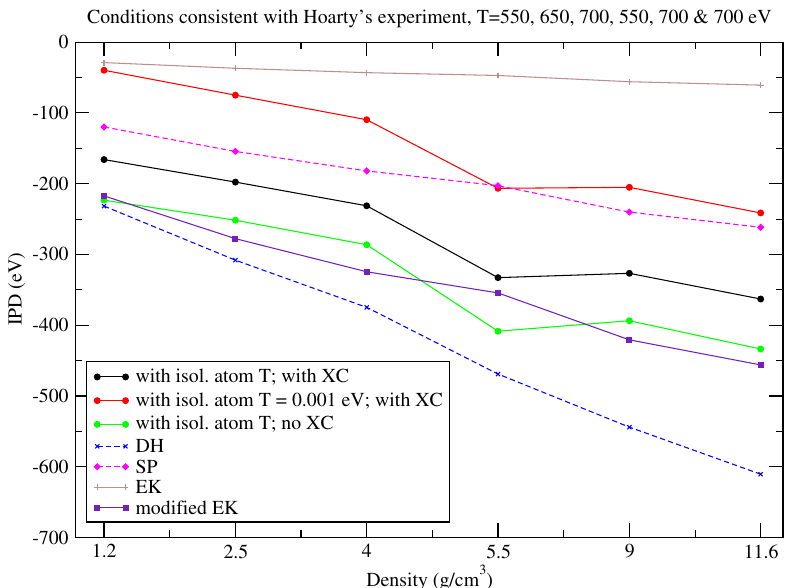
Figure 6. IPD of the different charge states for an aluminum plasma with different models in conditions related to Hoarty’s experiment with different modeling options. Black: this work with exchange-correlation and subtracted unscreened atom contribution taken at the expected plasma temperature, red: the same but with subtracted isolated-atom contribution taken at T = 0.001 eV, green: this work without exchange-correlation and subtracted unscreened atom contribution taken at the expected plasma temperature, dashed blue: Debye-Hückel, magenta: Stewart-Pyatt, brown: Ecker-Kröll and purple: modified